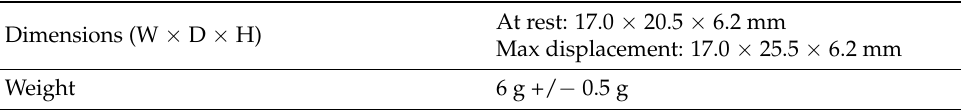
( b ) Figure 2. ( a ) Overview of designing the Lofelt L5 actuators along the forearm; and ( b ) an example of a wearable vibrotactile sleeve and the configuration of the actuators. A Prusa Slicer and a Prusa MK3s 3D printer were used to print the actuator housing. The fabric works as a scaffold to hold the actuators in place on a flexible and elastic